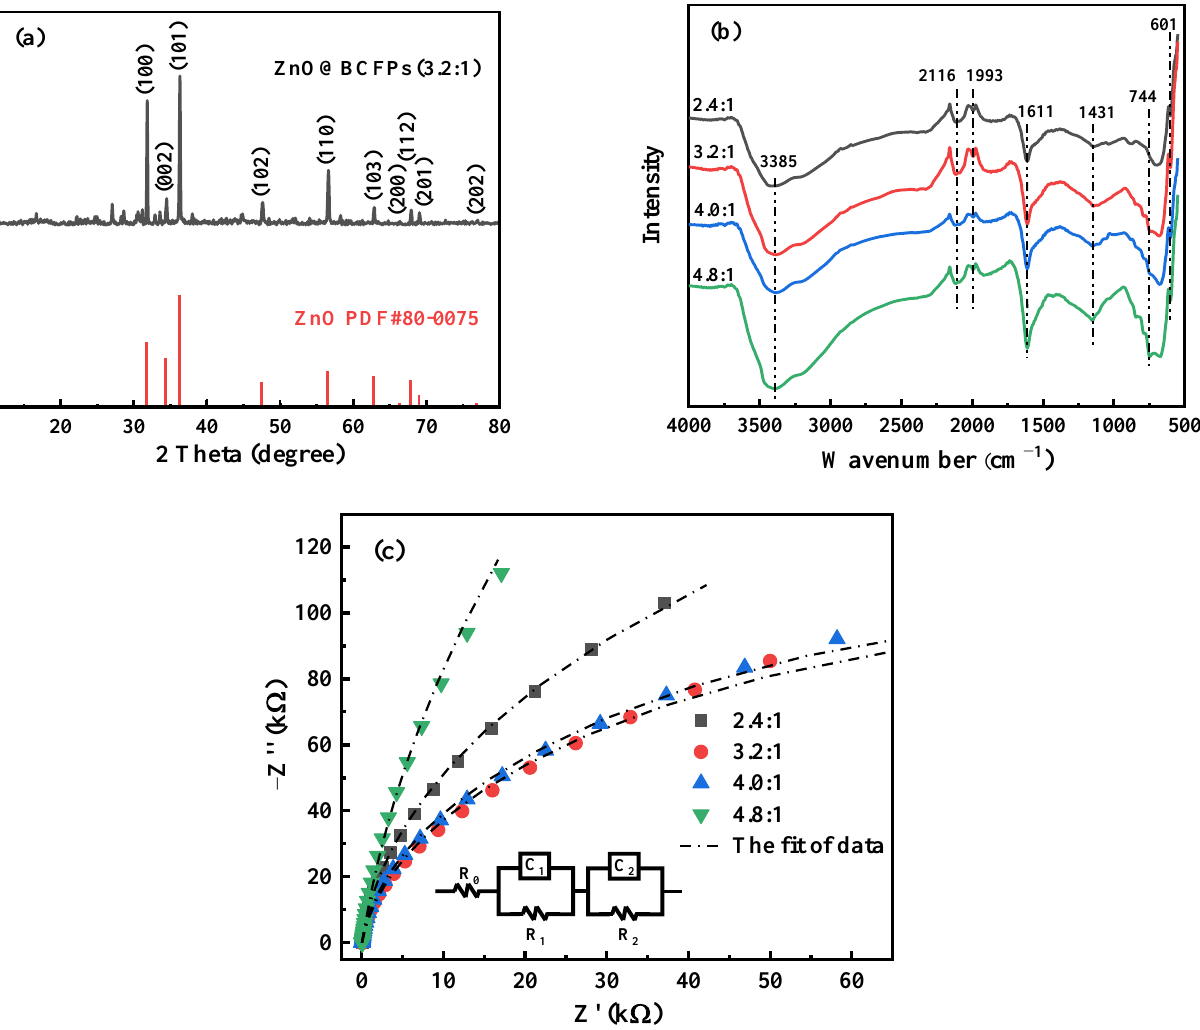
Figure 2. Characterization of particle electrode: ( a ) XRD, ( b ) FTIR and ( c ) EIS. Table 1. The fitted parameters of EIS data for particle electrodes with different mass ratio of ZnCl 2 to eucalyptus sawdust.